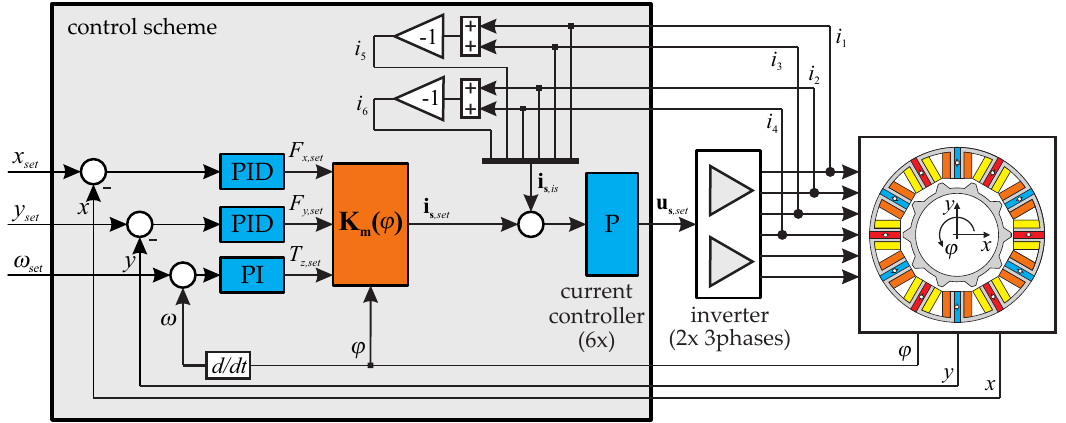
Figure 10. Block diagram of the nonlinear feedback control scheme for controlling the double three-phase bearingless flux-switching slice